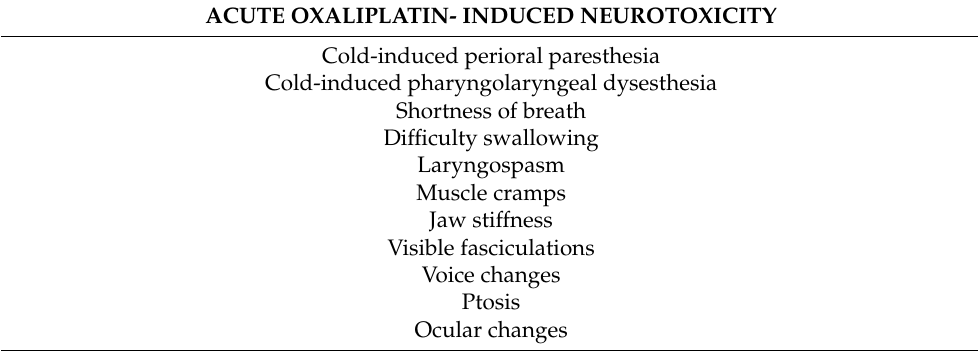
Table 2. Acute symptoms or signs of OXA induced